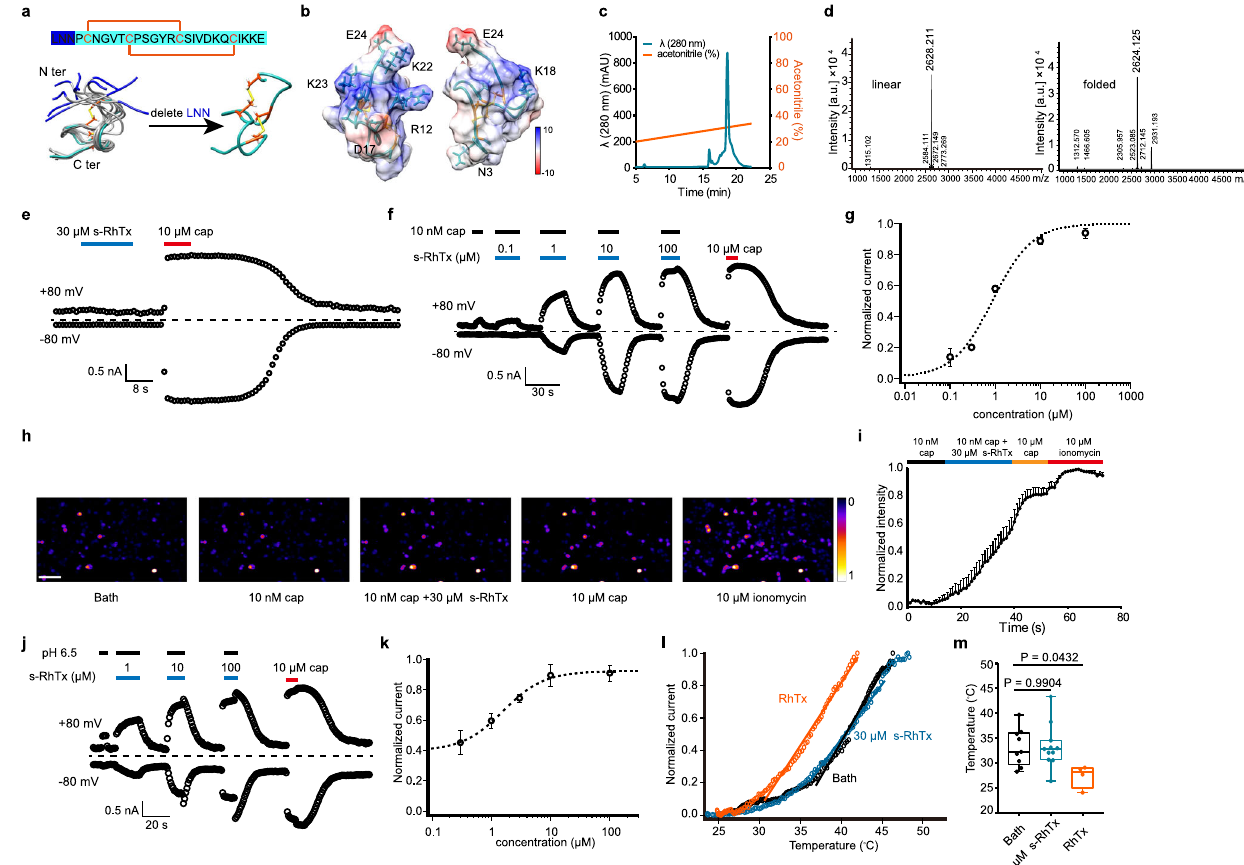
Fig. 1 | Rational design and identi fi cation of s-RhTx as a positive allosteric modulator of TRPV1. a Top panel, the amino acid sequence of RhTx and s-RhTx (highlightedincyan);bottompanel,structurecomparisonofRhTx(PDBID:2MVA, colored in gray; the extra three residues in N terminus highlighted in blue) and s-RhTx (colored in cyan and disul fi de bonds were labeled in orange). b Structural modelofs-RhTxwiththe electrostaticpotential (kcal/mol/e)distribution shown in color(redand bluefornegativeandpositivecharge,respectively). c Puri fi cationof s-RhTx by reverse phase chromatography with the elutedconcentration of 31% for acetonitrileatthepeak. d Massspectrometryanalysisshowedthemolecularweight oflinear(left)andoxidative(right)s-RhTx. e s-RhTxcannotactivateTRPV1channel. f s-RhTx potentiates the effect of 10nM capsaicin on TRPV1 in a concentration- dependent manner. g Concentration – response relationships of s-RhTx in the pre- sence of 10nM capsaicin fi tted to a Hill equation (data were represented as mean±S.E.M., n =4 biologically independent cells). h Calcium imaging in TRPV1- expressing HEK293T cells responded to 10nM capsaicin, the mixture of 10nM